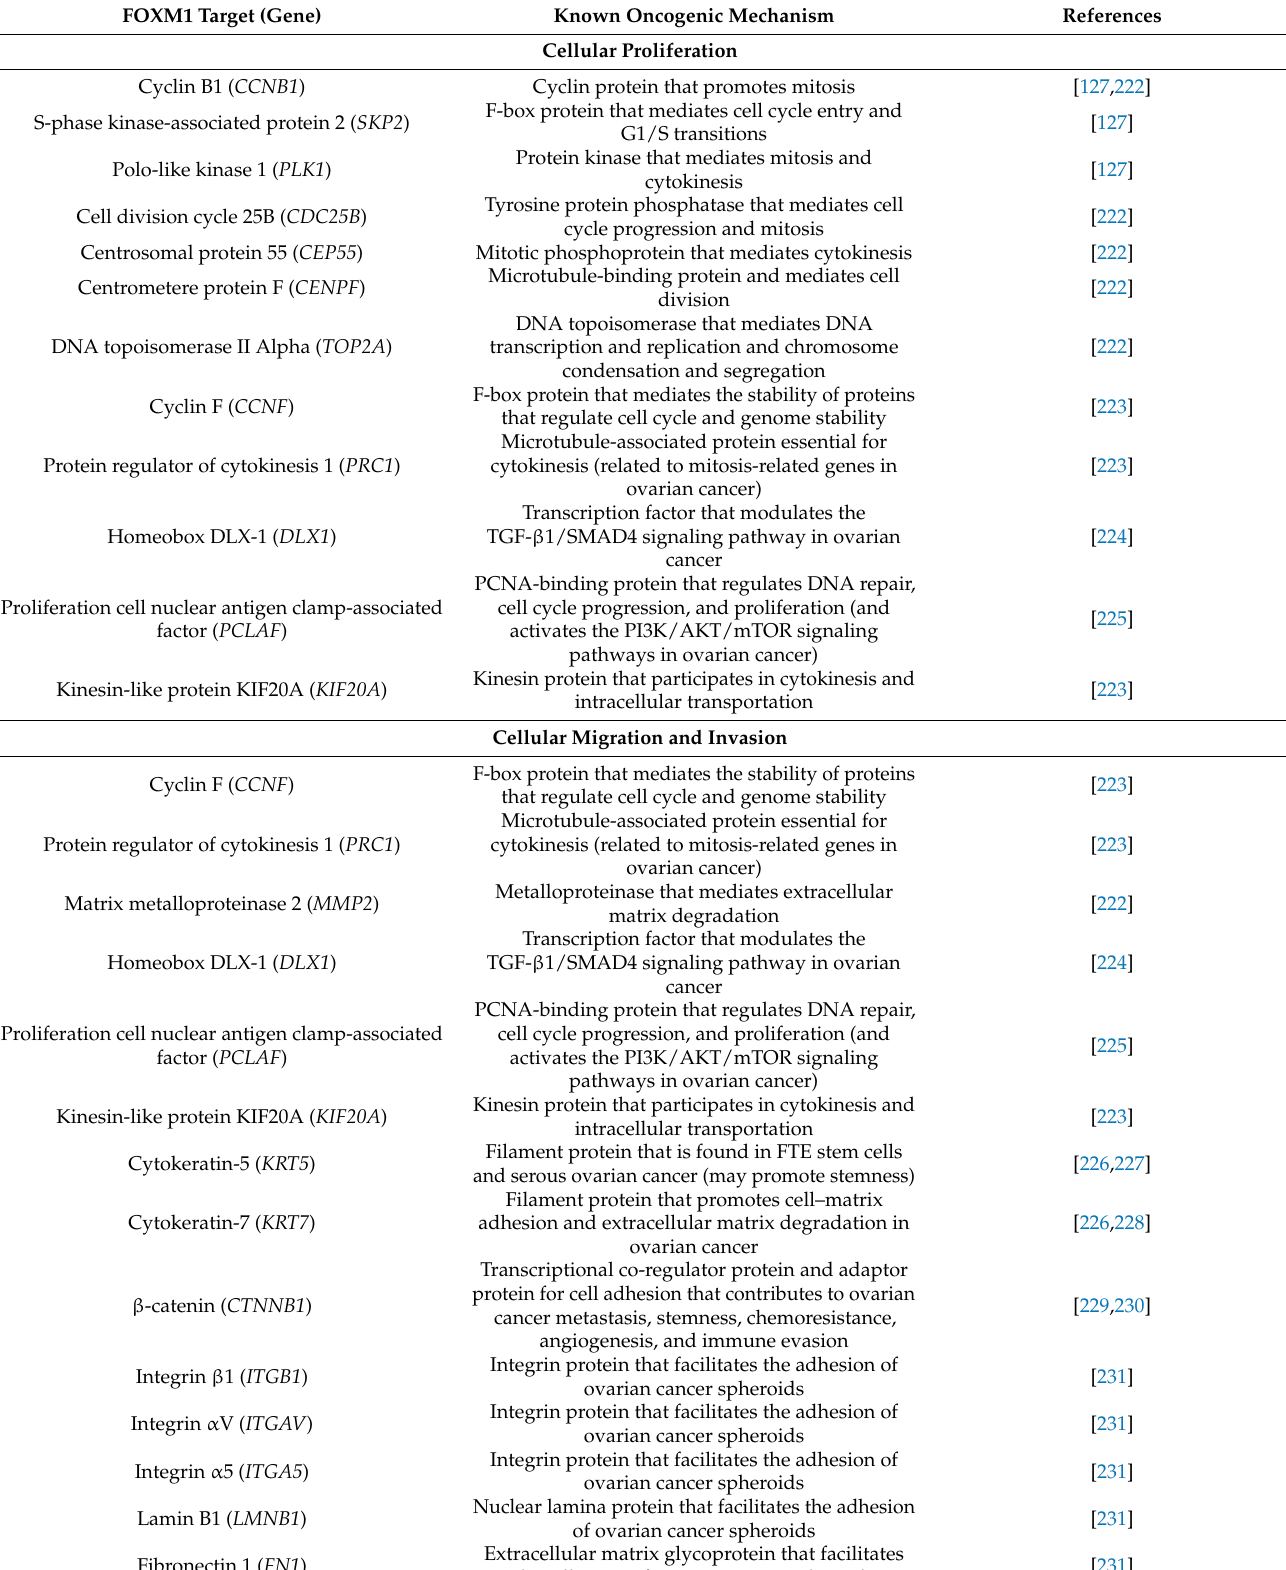
Table 2. FOXM1 target genes and their